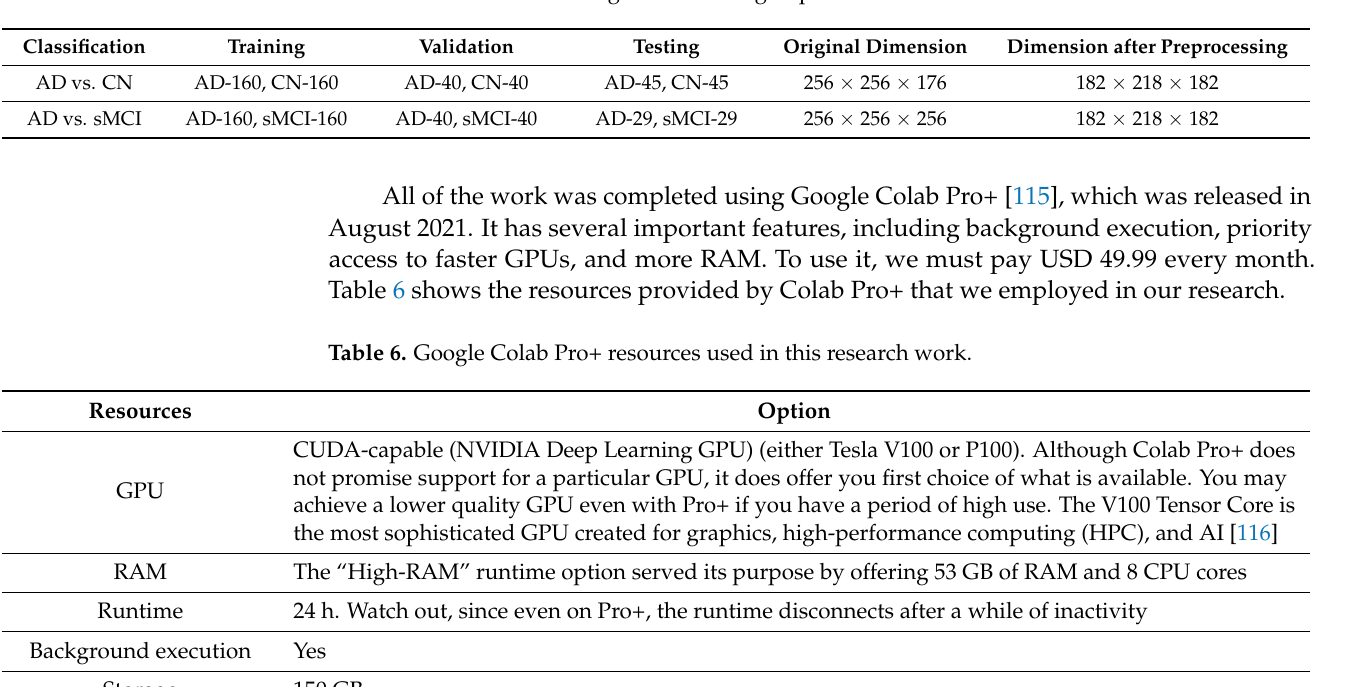
Table 5. Number of MR images used during implementation work.